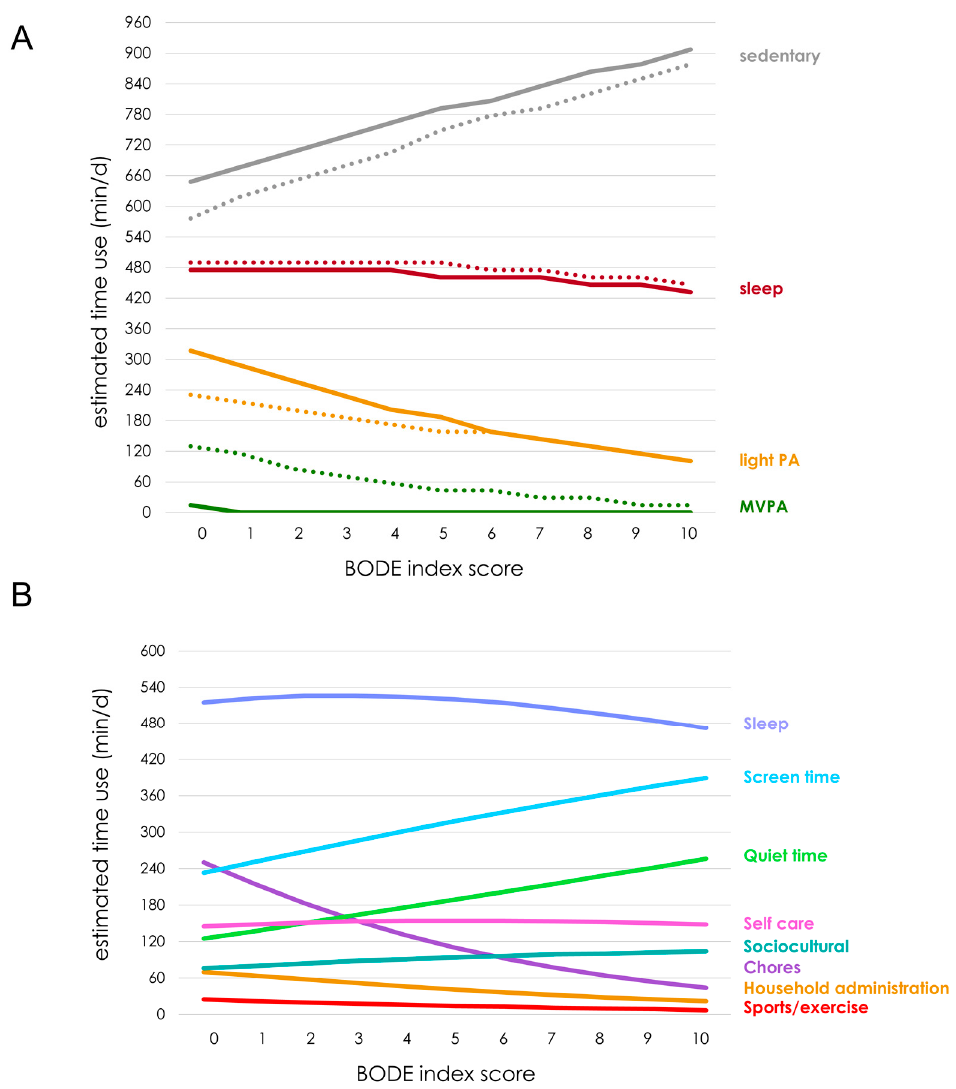
Figure 3. Estimated daily time use (in min/d) for components across the BODE index. BODE index—the Body mass, airflow Obstruction, Dyspnoea and Exercise index, Light PA—Light physical activity, MVPA—moderate to vigorous physical activity, min/d—minutes per day. Data are expressed as means derived from compositional models (i.e., geometric means of components, adjusted to collectively sum to a total of 1440 min/day). ( A ) Predicted time use using energy expenditure bands (accelerometry estimates are shown with solid lines, and MARCA estimates are shown with dashed lines); ( B ) Predicted time use using MARCA super domain categories.